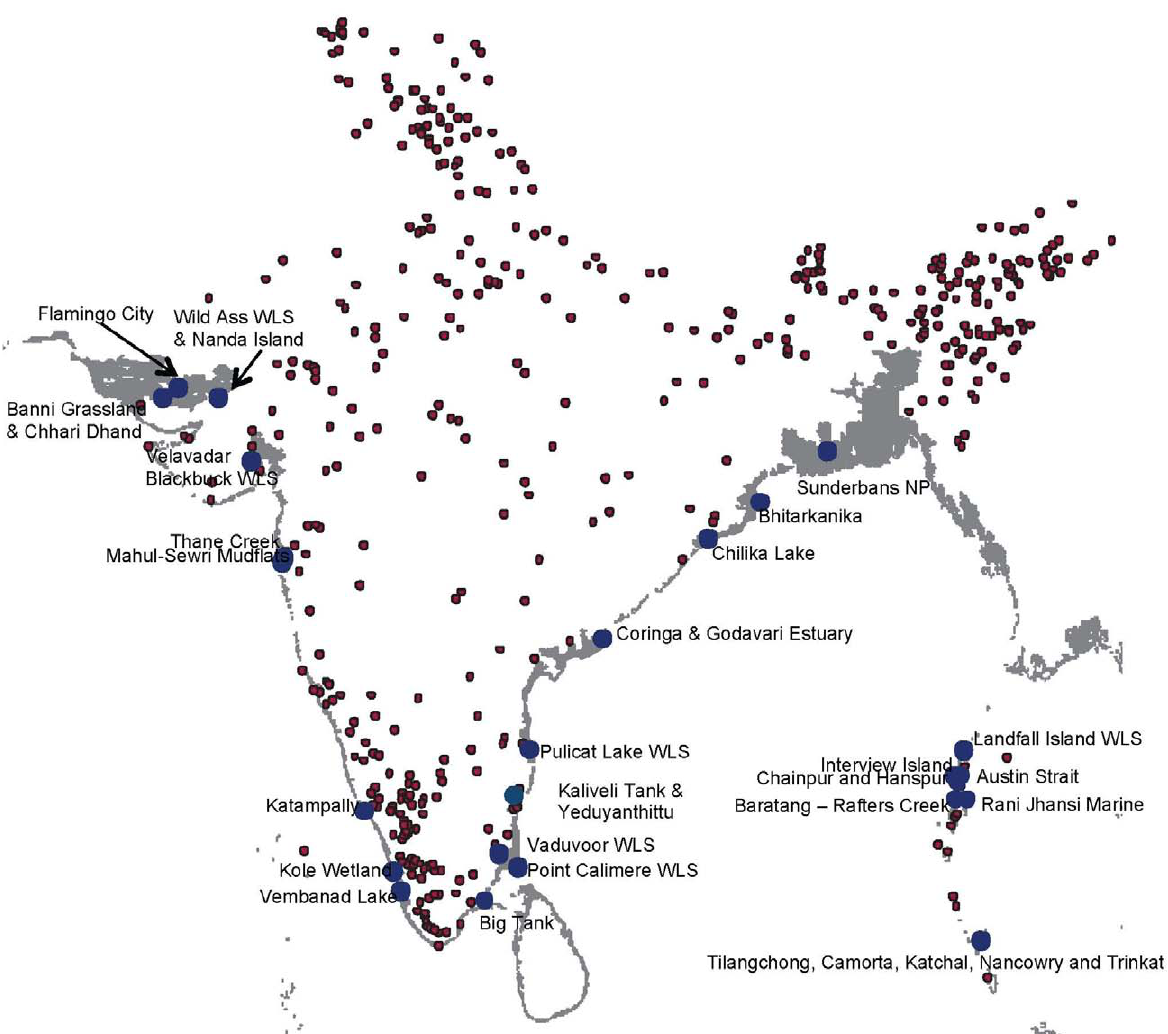
Figure 1b. Important Bird Areas (IBAs) directly affected by 6m sea-level rise, shown as solid blue circles. Other IBAs are shown as red circles and inundated areas appear in